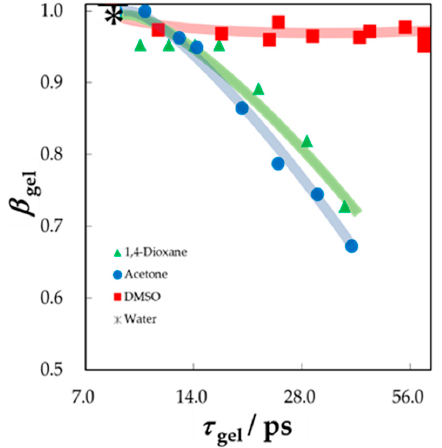
Figure 10. The τ – β diagram for solvent mixtures in gels. The symmetric relaxation time distribution parameter β gol of Cole-Cole equation was used for aqueous solutions of 1, 4-dioxane and acetone, and the Havriliak-Negami equation was used for aqueous solutions of dimethyl sulfoxide ( DMSO).